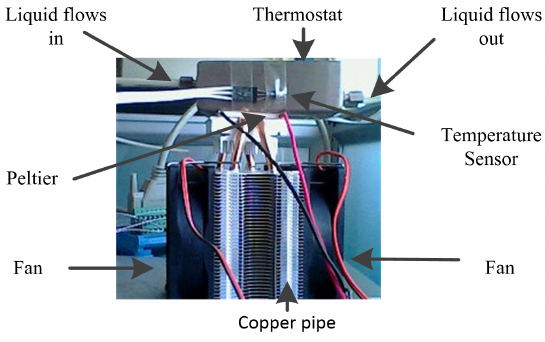
Figure 1. Experimental system.